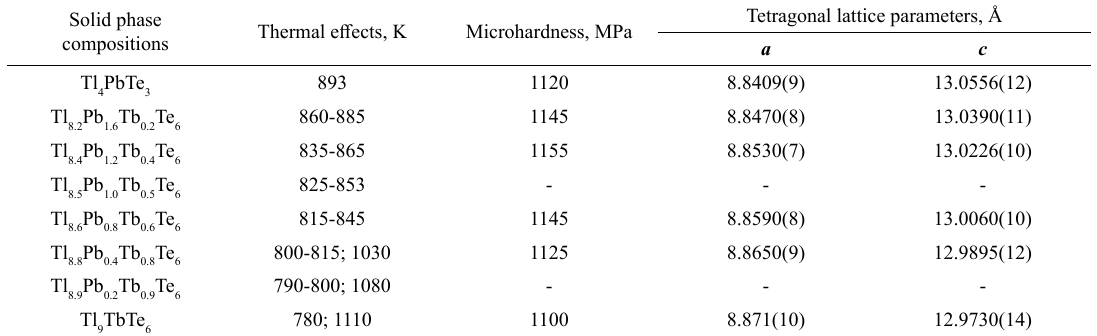
PbTe -Tl TbTe section 4 3 9 6